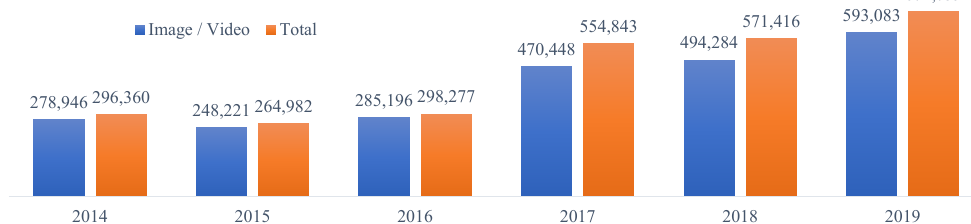
Figure 1. The number of corrective recommendations for copyright infringements reported by the